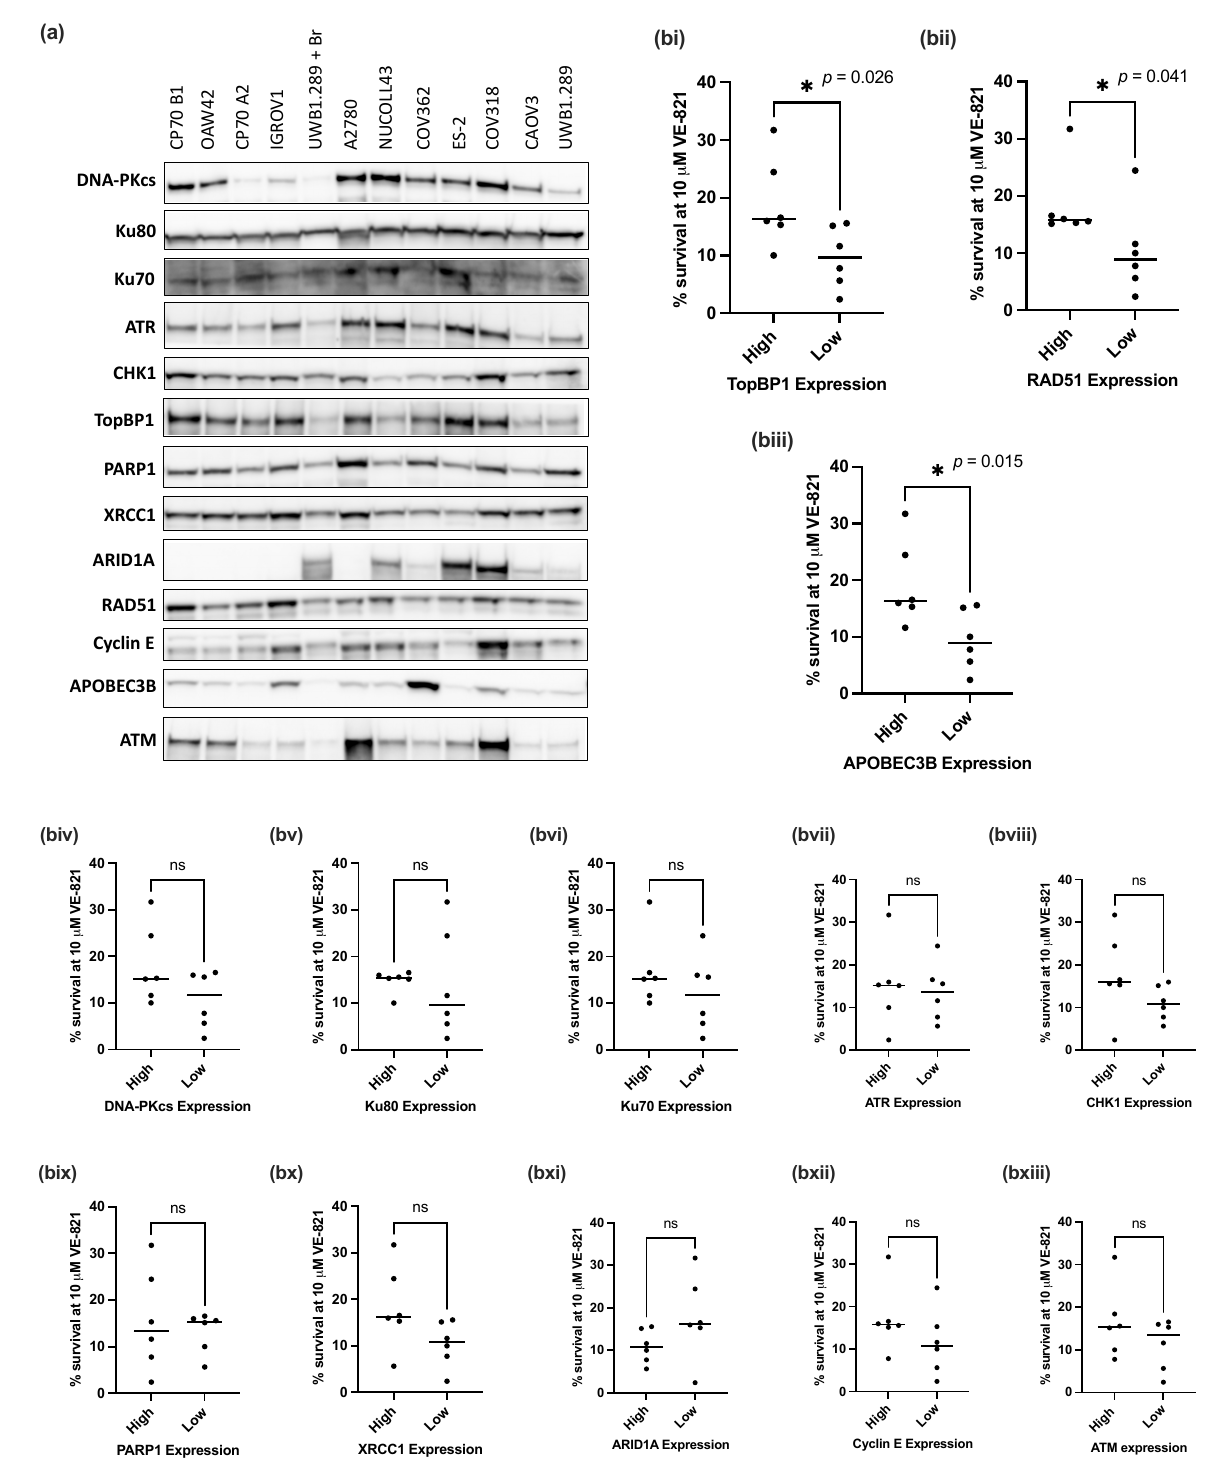
Figure 2. Measurement of previously identified determinants of sensitivity to ATRi. ( a ) Representa- tive Western blot of 3 independent experiments. ( b ) Mean survival at 10 µ M VE-821 of cell lines split into high (above the median) or low (below the median) normalized protein expression for each of the following proteins: ( i ) TopBP1, ( ii ) RAD51, ( iii ) APOEB3B, ( iv ) DNA-PKcs, ( v ) Ku80, ( vi ) Ku70, ( vii ) ATR, ( viii ) CHK1, ( ix ) PARP1, ( x ) XRCC1, ( xi ) ARID1A, ( xii ) Cyclin E, ( xiii ) ATM. Data points are individual cell lines. The horizontal black bar indicates median survival of each group of cell lines. * p < 0.05; ns, not significant (Mann–Whitney